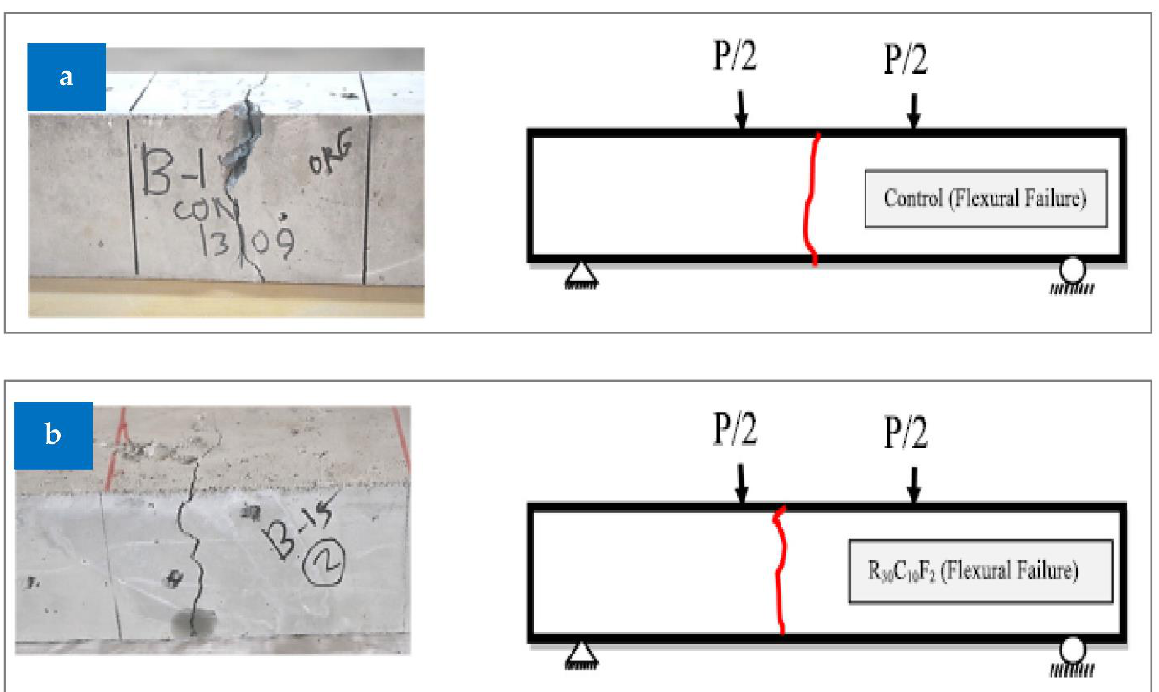
Figure 16. Beam failure: ( a ) reference and ( b ) combination of RCA, rubber, and fibers [44]: used as per Elsevier permissions. per Elsevier